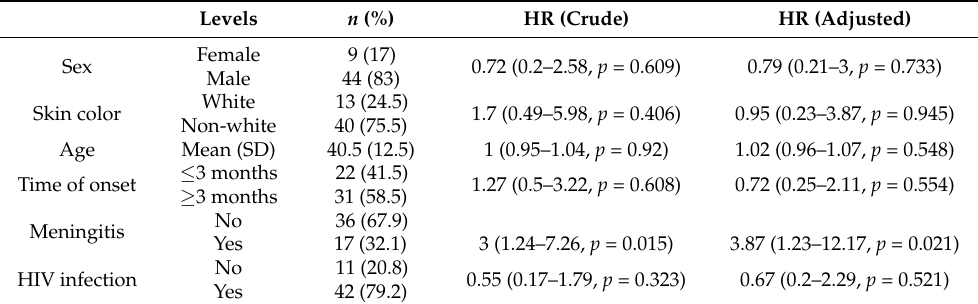
Table 2. Crude and Adjusted Hazard Ratios (HR) by Cox regression models for overall survival in 53 patients with disseminated sporotrichosis at